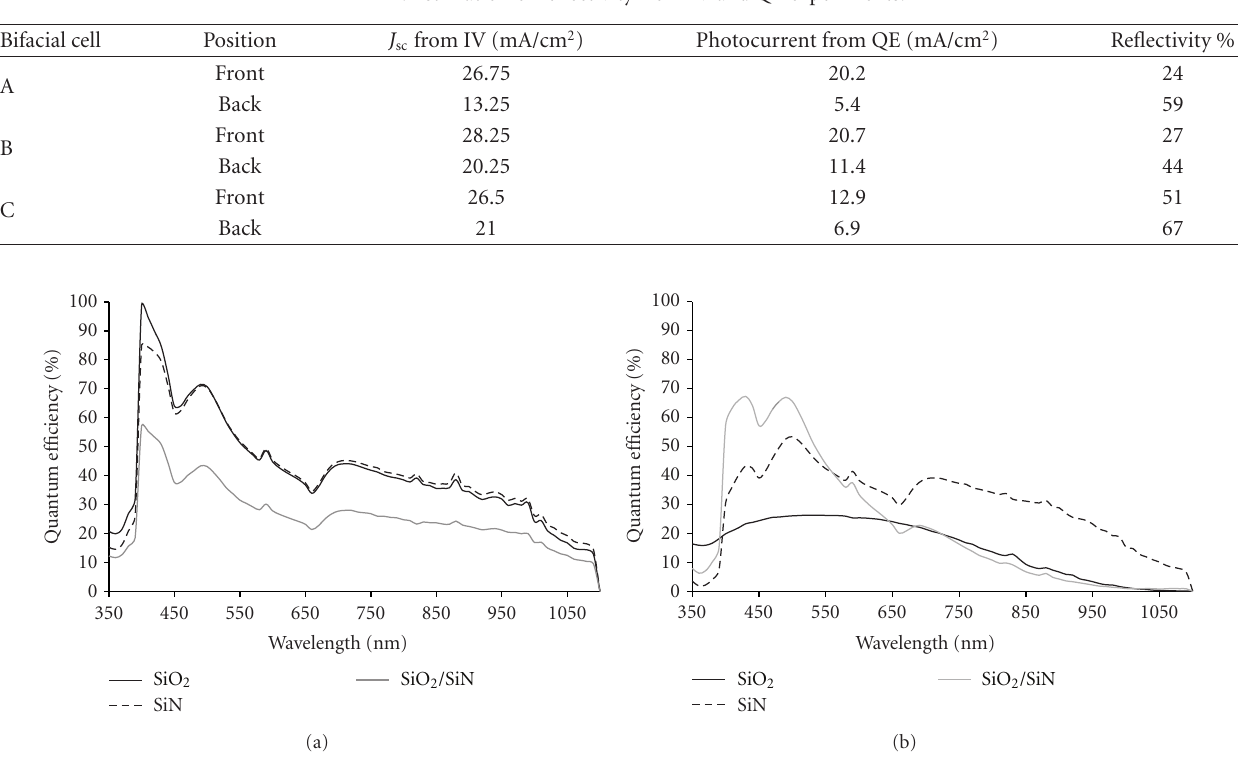
Table 2: Estimation of reflectivity from IV and QE experiments.